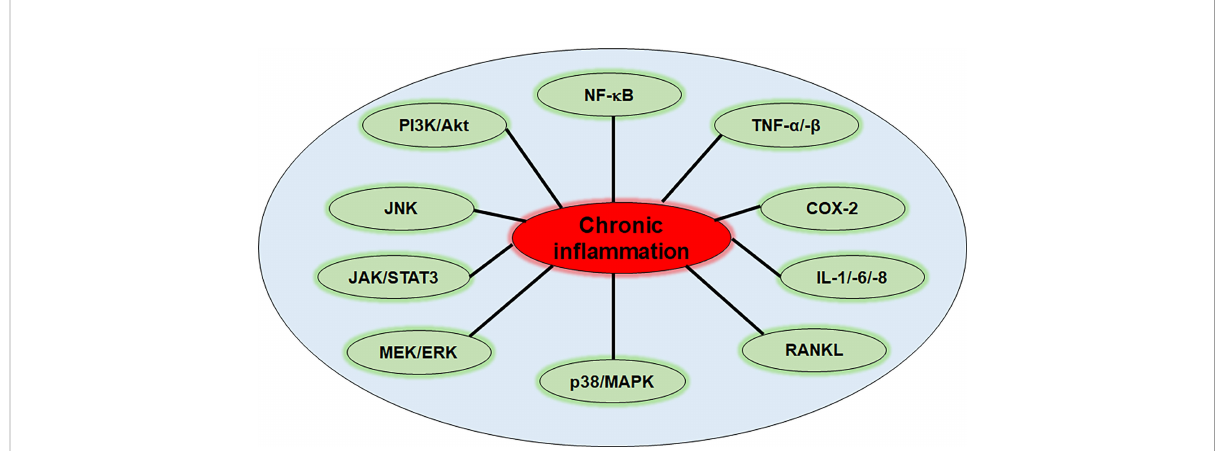
FIGURE 1 In fl ammation-related pathways in chronic diseases. NF- k B, nuclear factor kappa-light-chain-enhancer of activated B-cells; TNF- a /- b , tumor necrosis factor a / b ; COX-2, cyclooxygenase-2; IL-1/-6/-8, interleukin-1/-6/-8; RANKL, receptor activator of NF- k B ligand; p38/MAPK, protein kinase of 38 kDa/mitogen-activated protein kinase; MEK/ERK, mitogen-activated protein kinase kinase/extracellular signal-regulated kinase; JAK/STAT3, Janus kinase/signal transducer and activator of transcription 3; JNK, c-Jun N-terminal kinase; PI3K/Akt, phosphoinositide 3-kinase/ serine-threonine protein kinase